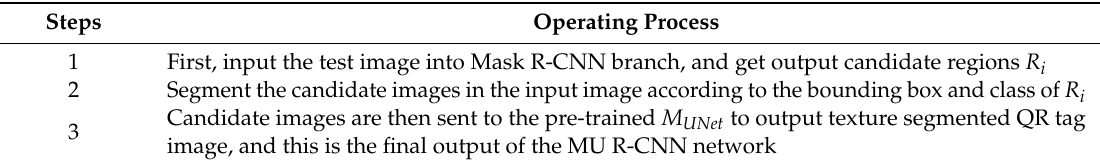
Table 3. Prediction process of total MU